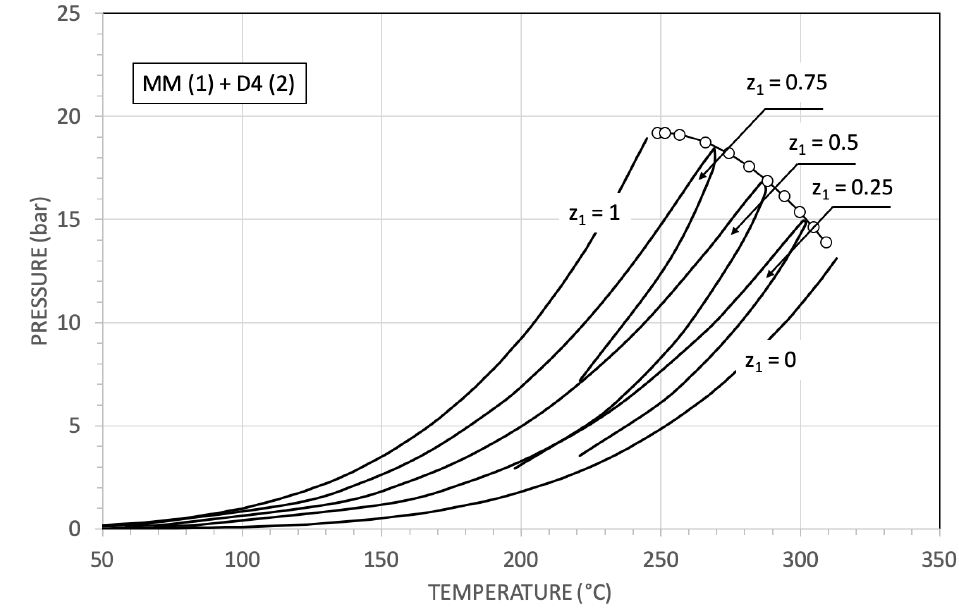
Figure 10. Pressure-temperature envelopes and critical locus for mixtures of MM/D 4 at different molar composition.